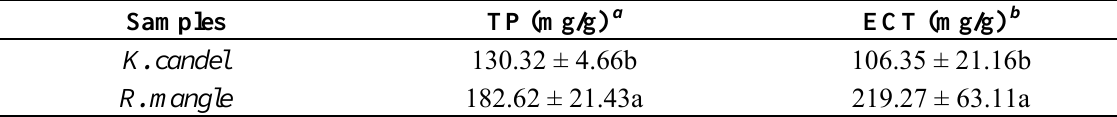
Table 1. The contents of total phenolics (TP) and extractable condensed tannins (ECT) from K. candel and R. mangle